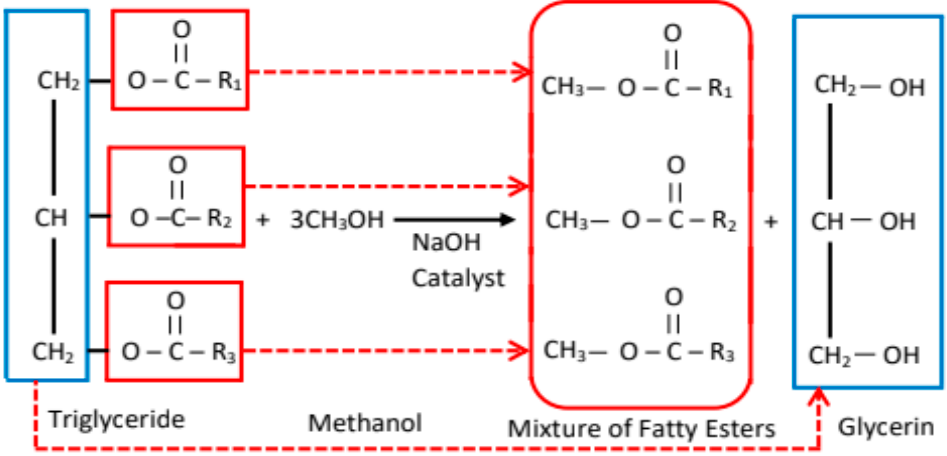
Figure 2. Chemistry of fatty acid methyl ester